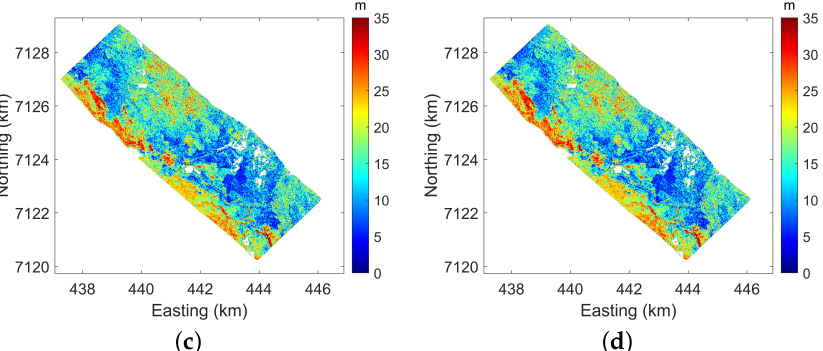
Figure 9. The forest height inversion results of P-band in different configurations. The color ramps ranges from 0 to 35 m. ( a ) TSIA + EBCR + LUT. ( b ) TSIA + IEBCR + ILUT. ( c ) TSIA + EBCR + ILUT. ( d ) TSIA + IEBCR + LUT.